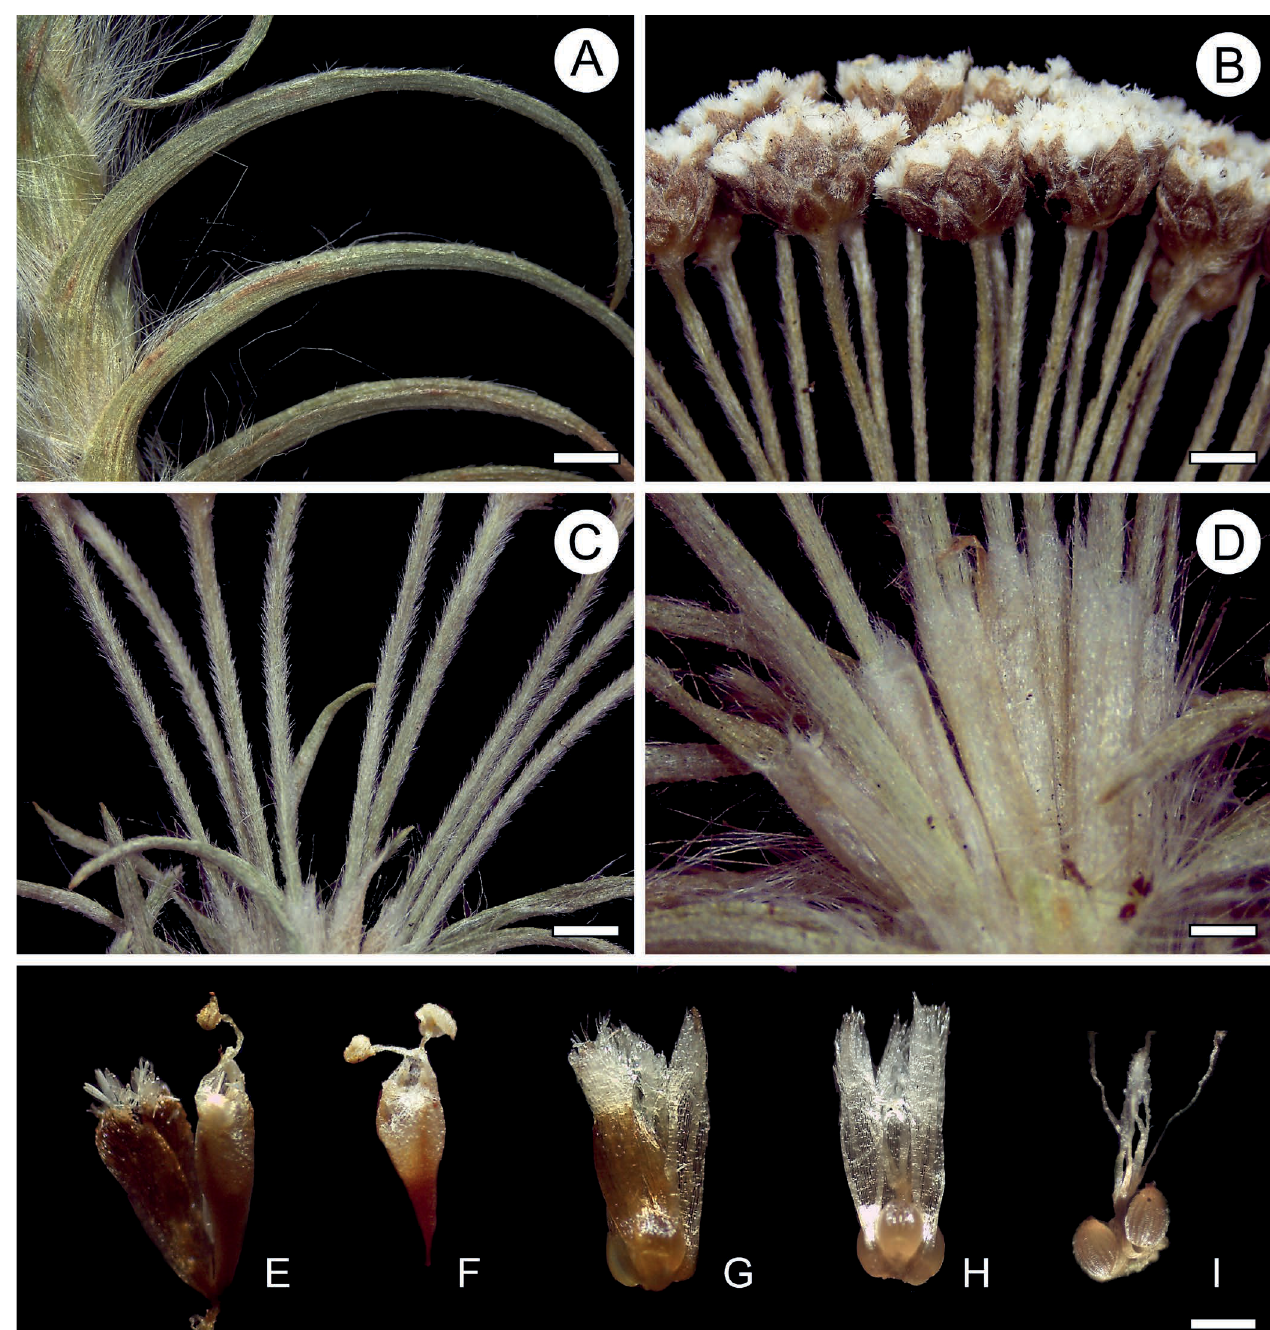
Figure 2 – Details of Paepalanthus decumbens (from Picanço et al. 69, R). A, leaf details; B, capitulum details; C, scape details; D, sheath details; E, staminate flower with floral bract and one sepal removed; F, staminate flower with sepals removed; G, pistillate flower; H, pistillate flower with sepals removed; I, fruit releasing the seeds. Scale bars: A = 2 mm; B = 1.5 mm; C = 5 mm; D = 1 mm; E–I = 0.75 mm. Photographs: W.L.